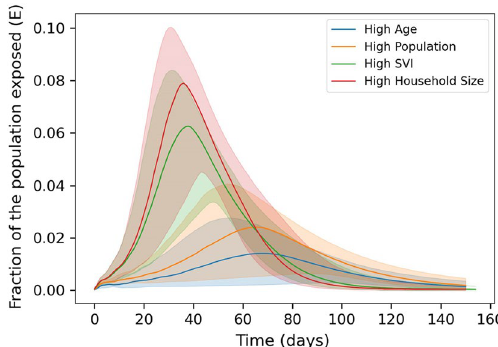
Fig. 7 Fraction of the population exposed as a function of time. Plot includes the median (line) and standard deviation (shaded region) for each community from the full set of